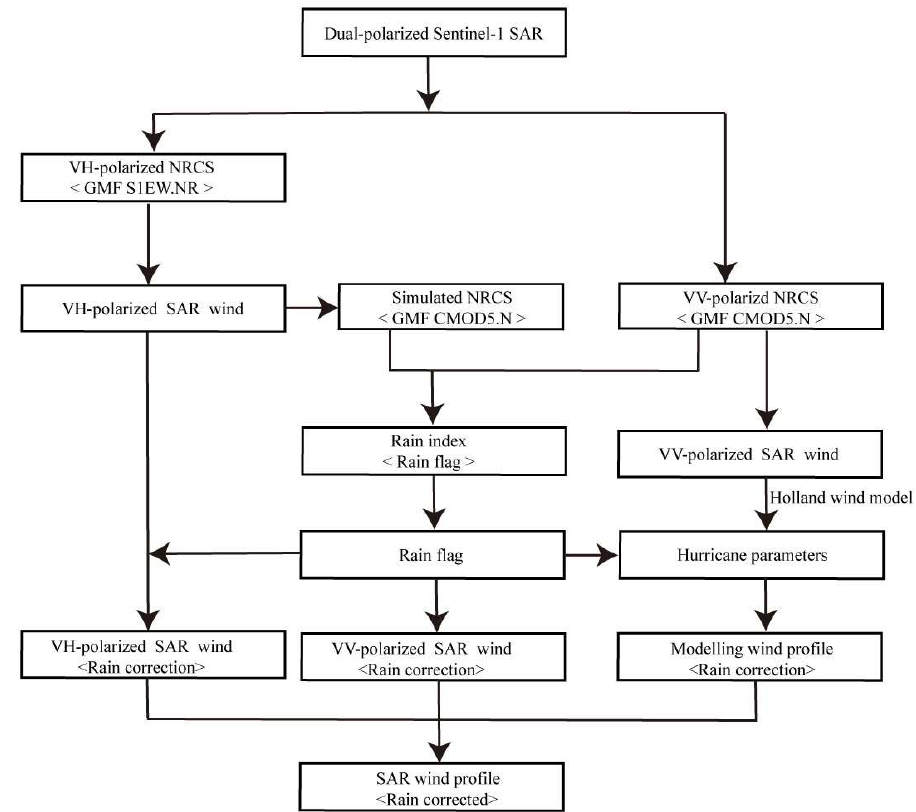
Figure 6. Flowchart of the proposed methodology.